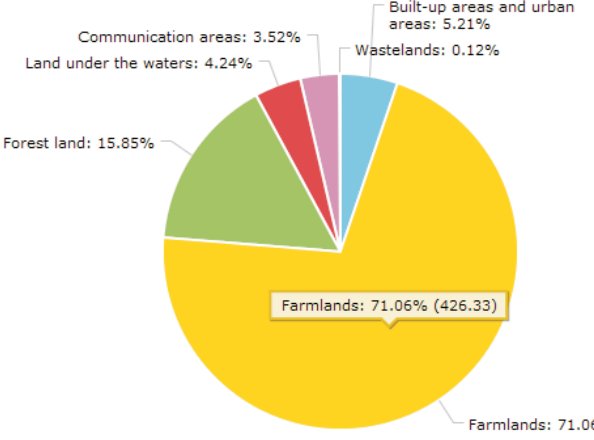
Fig. 2. Data visualization using amChart library, diagram in its original form